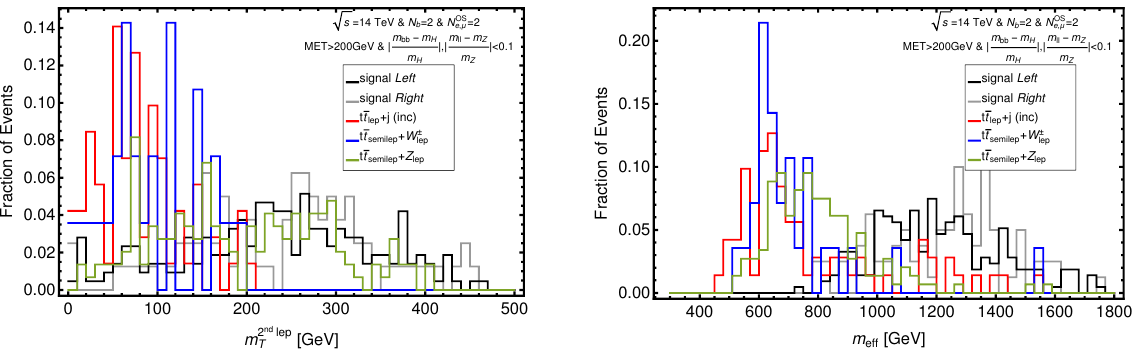
nd lep ( left ) and the effective T